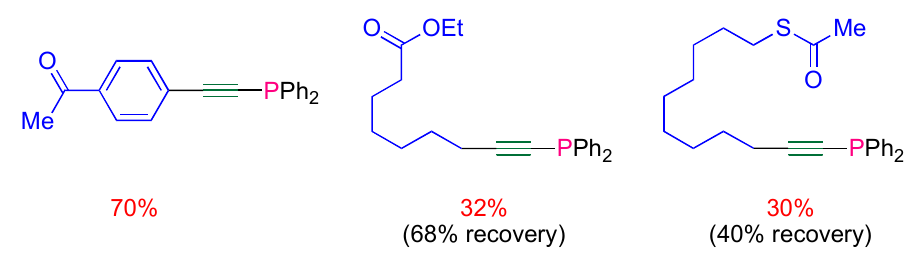
Figure 1. Functionalized alkynylphosphines synthesized via the nickel-catalyzed